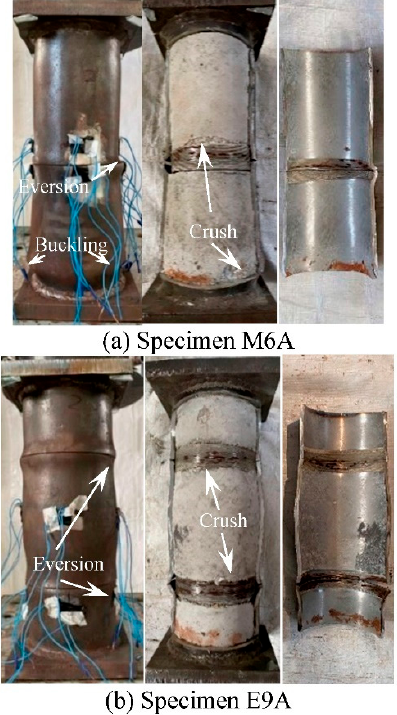
Figure 7. Failure modes of specimens with short thread.